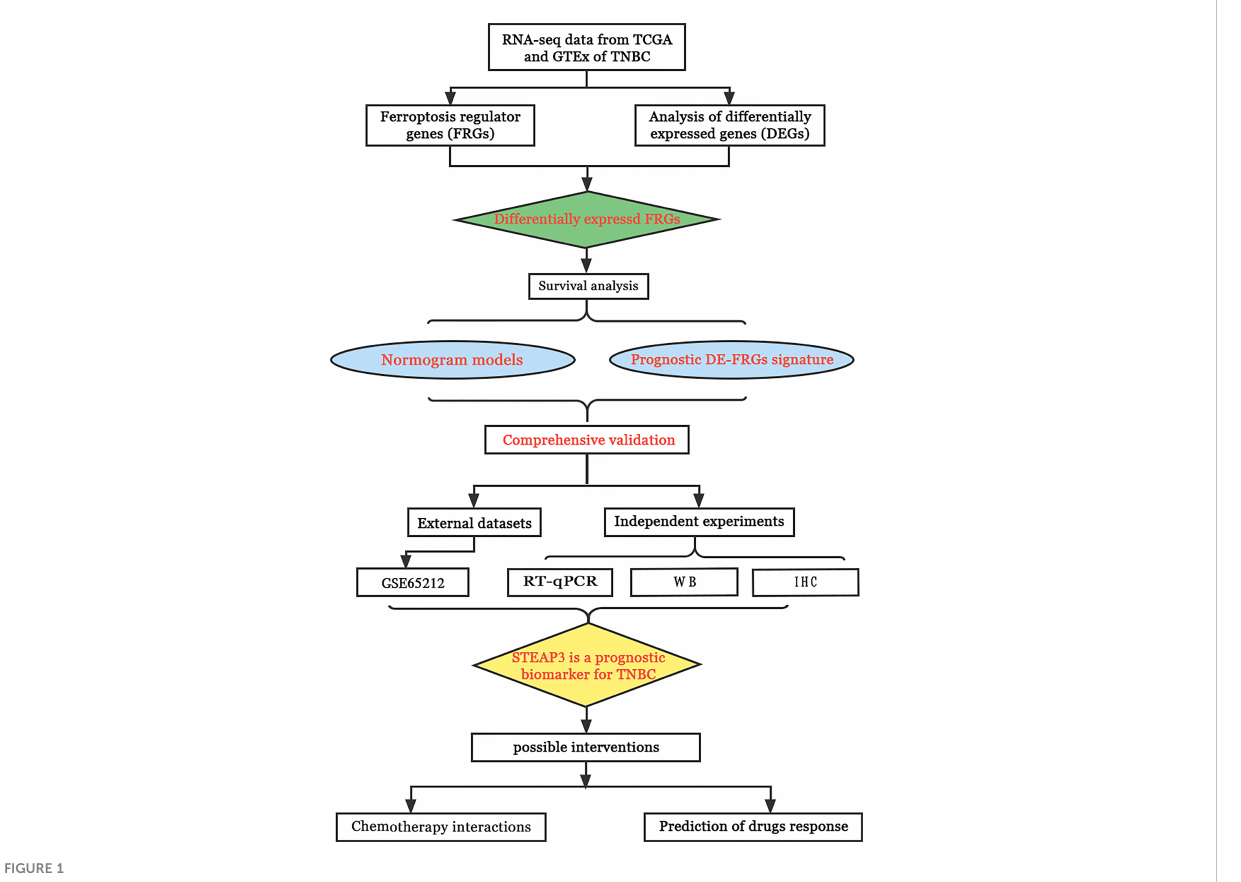
FIGURE 1 The schematic representation of the study work fl